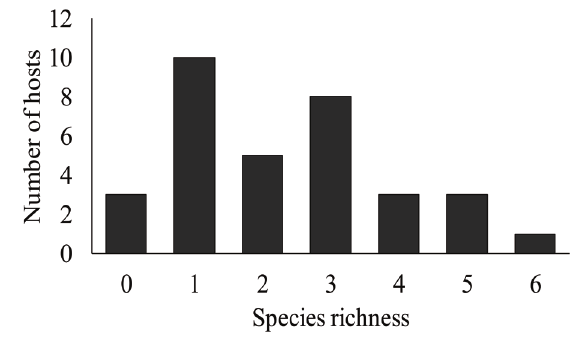
Figure 3 - Weight-length relationship for Astronotus ocellatus from the Fortaleza Igarapé basin, in the eastern Amazon (Brazil) parasitized (l) and non-parasitized